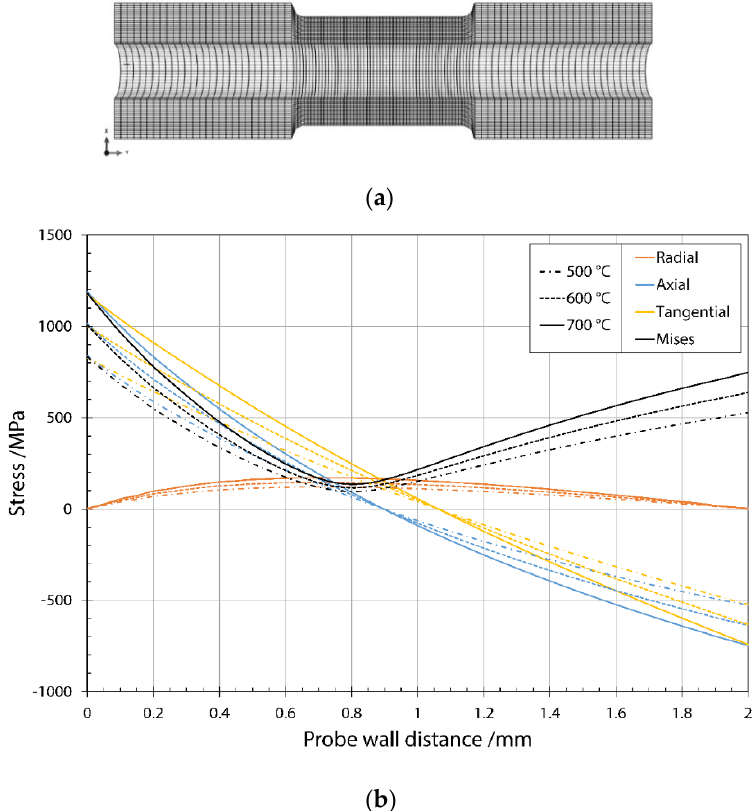
Figure 1. ( a ) Meshed finite element model of the sample, and ( b ) stress distribution through the sample wall at 700 °C (solid line), 600 °C (dashed line) and 500 °C (dashed dotted line).